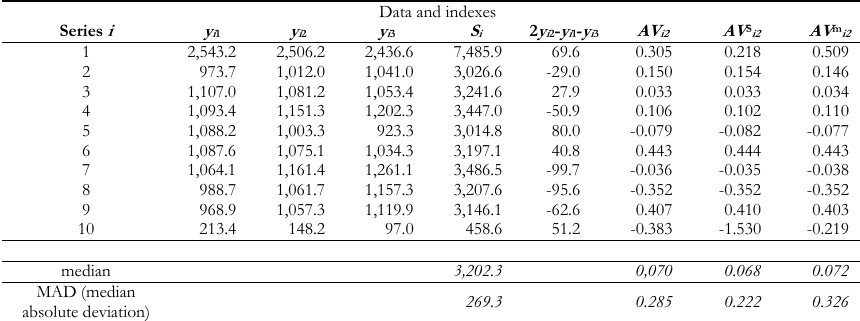
Data of example in figure 7 and